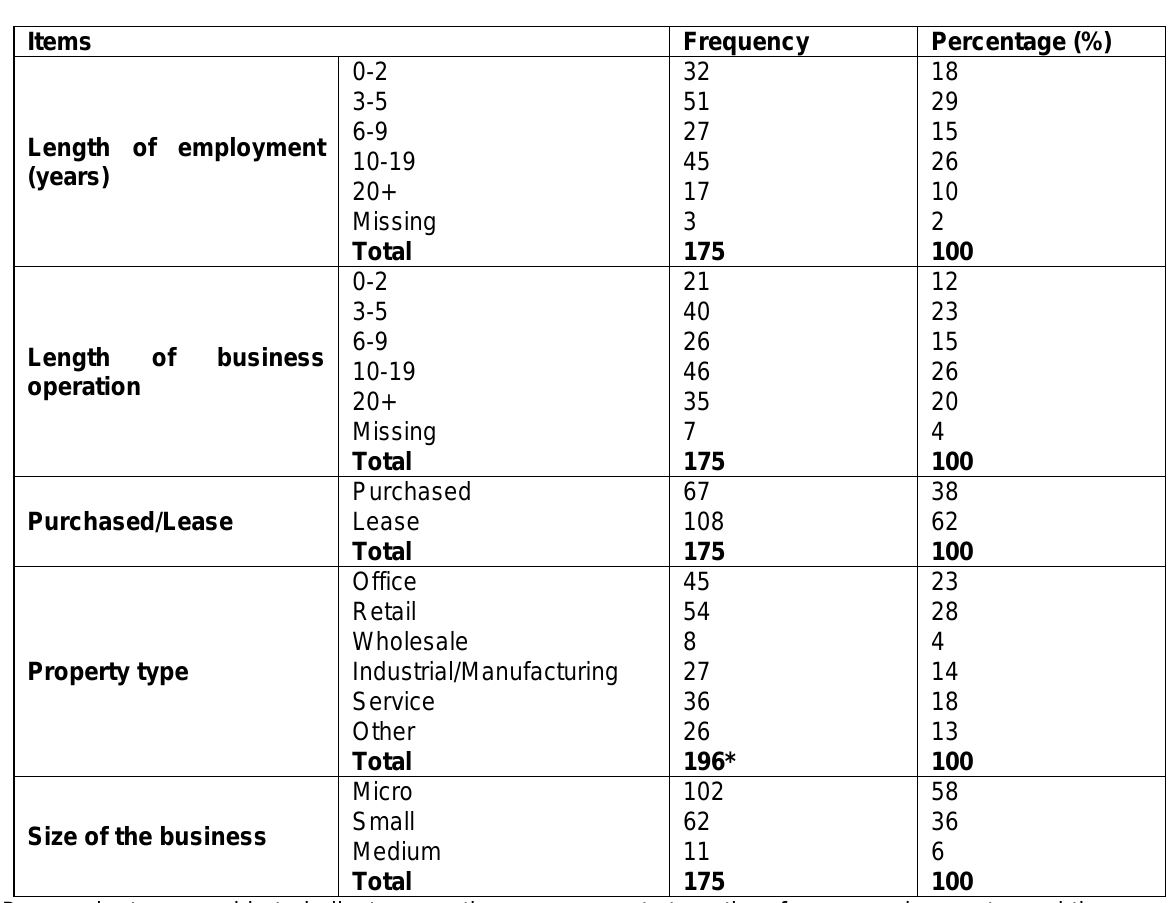
Table 2: D emographical data of respondents’